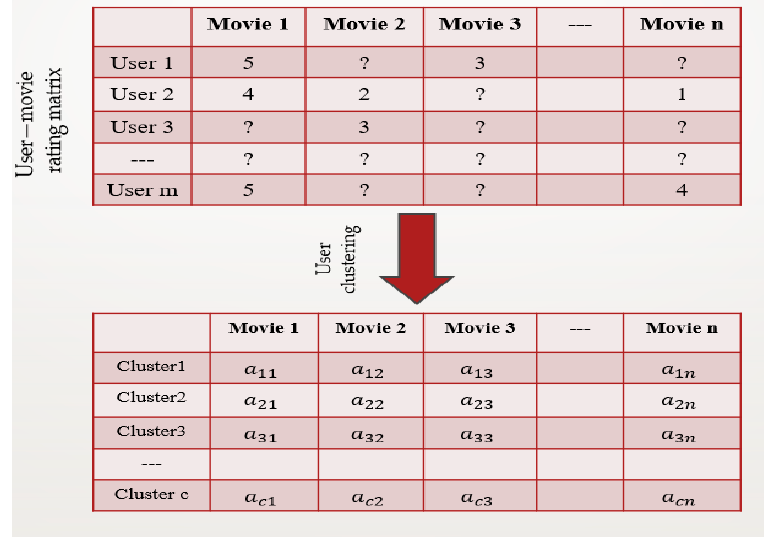
Figure 3. Customer clustering.